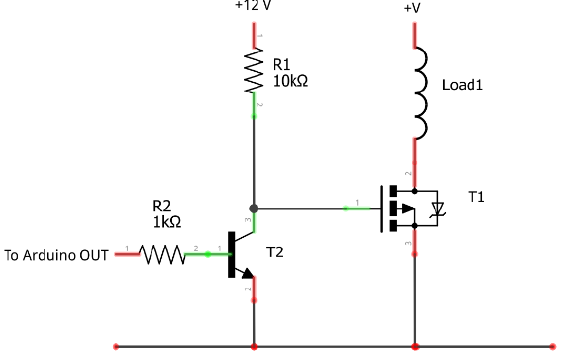
Figure 12. Connection diagram for the intensity regulator of the artificial lighting system based on LED technology.